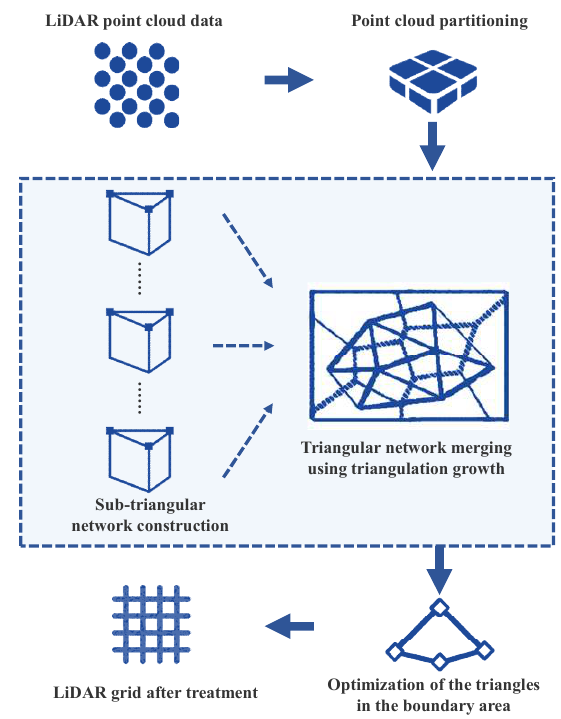
Figure 1. The overall procedure of the paralleled Delaunay triangulation